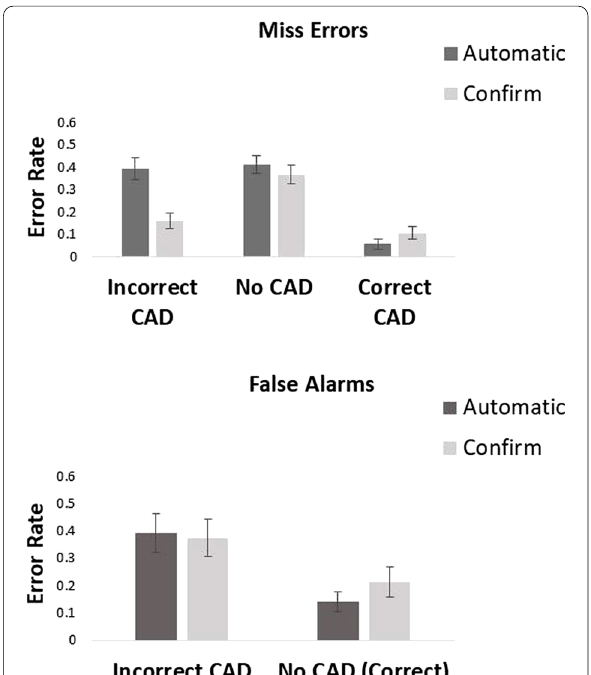
Fig. 5 Proportion of miss errors and false alarms in the automatic and confirm conditions of Experiment 2 Fig. 6 D ′ and c values for the automatic and confirm conditions in